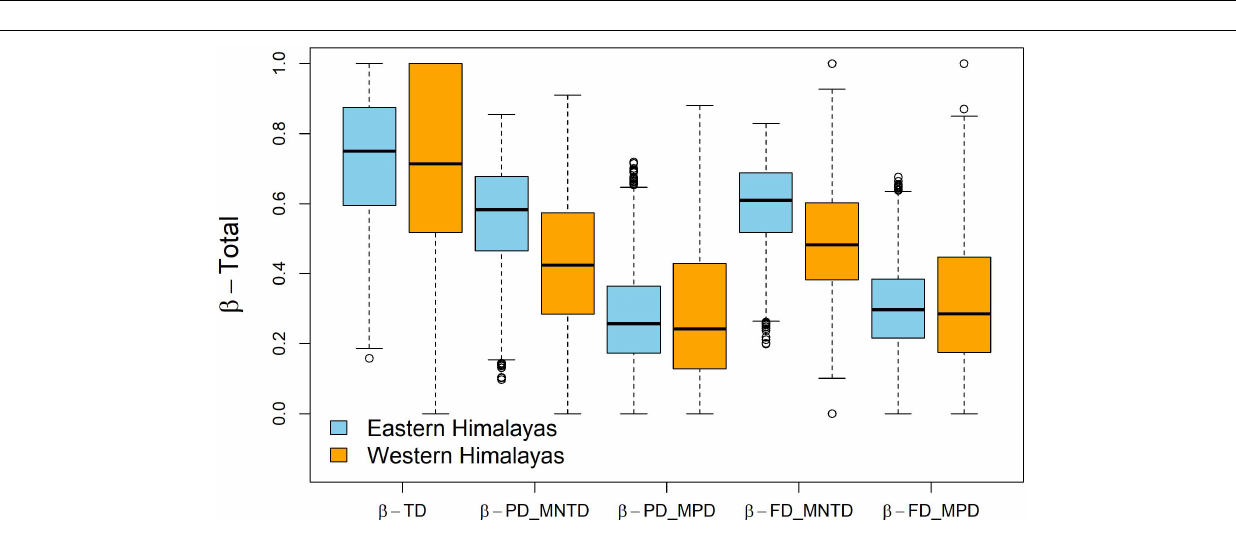
FIGURE 3 | Box-whisker plots showing pair-wise taxonomic, phylogenetic and functional β -total (Sørensen’s pairwise dissimilarity) in river bird communities in the E and the W Himalaya based on field surveys in winter. TD, Taxonomic Diversity; FD, Functional Diversity; PD, Phylogenetic Diversity; MPD, Mean Pair-wise Distance; MNTD, Mean nearest taxon